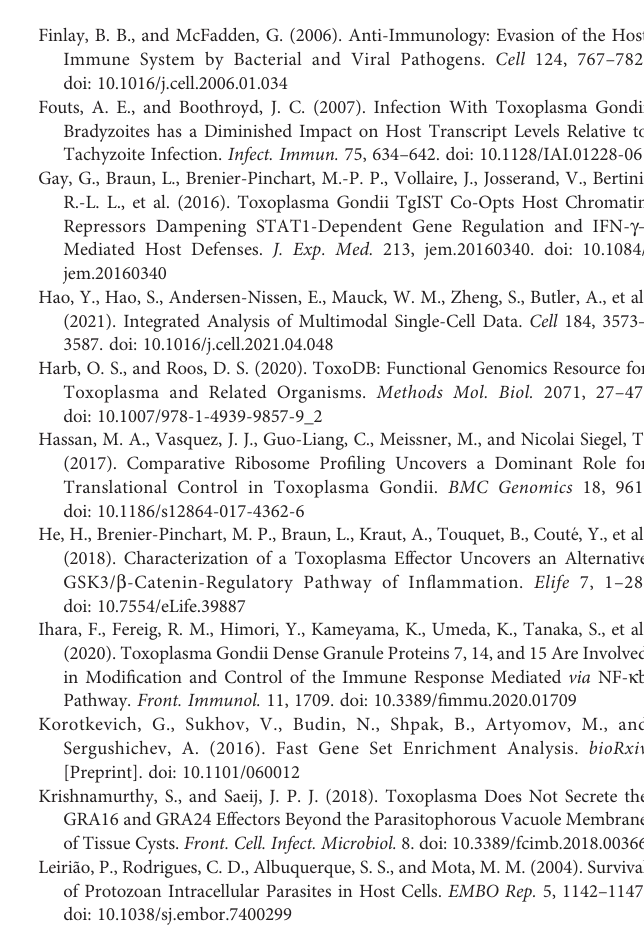
analysis (GSEA) are shown as a size of circle to cover the large variety. Enriched pathways for upregulated genes are shown in red and those for downregulated genes are shown in blue. Enriched pathways with FDR less than 0.001 in at least one comparison are shown. Pathways with an FDR < 0.001 are shown as solid circles. B: BAG1+ cells, S: SAG1+ cells, DP (double positive): +/+, DN (double negative): ND/ND. Supplementary Figure S5 | Parasite gene expression in BAG1+HR-IvL and BAG1+#A-#F subsets. (A) Parasitic mRNA count for BAG1+HR-IvL and BAG1 +#A-#Fcellsareshown.Student ’ s t-testp-value is0.21. (B) Normalizedenrichment score (NES) and FDR values for gene set enrichment analysis (GSEA) are shown. NES > 0 means gene pathway enriched for the upregulated genes in BAG1+HR-IvL compared to BAG1+#A-#F. Enriched pathways with FDR less than 0.05 are shown with Extracellular gene set. (C) Counts per million reads mapped to parasite transcriptome (CPM) value for each gene per each cell were transformed to log1p- value; ln(CPM+1). Box plot to show the quantile values and violin plot to show the distributionofthevaluesareoverlayedwithdotplottoshowtheexpressionvaluefor each single cell. BAG1+HR-IvL and BAG1+#A-#F cell subsets are shown. Supplementary Figure S6 | Changes in parasitophorous vacuole number and size distribution over the six days of culturing in bradyzoite induction medium. (A) Infection rate and (B) the parasitophorous vacuole sizes were characterized on days 2, 4, and 6 of bradyzoite induction culture. Data from independent triplicate experiments are shown. Imagesfrom each replicateand each time point, namely, at least 200 host cells, were used for the analysis. No signi fi cant differences was observed in infection rate (one way ANOVA p-value = 0.36). *: adjusted p-value < 0.05, **: adjusted p-value < 0.01 with Tukey ’ s ‘ Honest Signi fi cant Difference ’